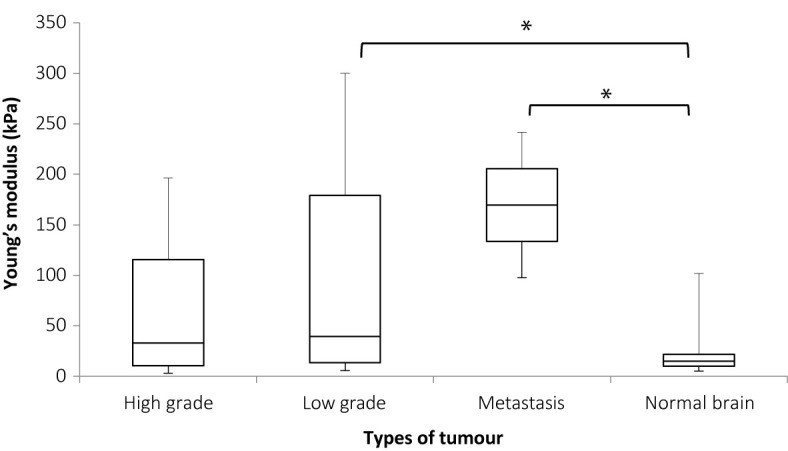
Box and whiskers plot of Young’s modulus distributions for various tumor types. The upper and lower bounds of the box were the third and first quartiles, respectively, while the line within the box was the median. The upper and lower whiskers were maximum and minimum values, respectively. *There was a significant difference between the Young’s modulus values for low grade tumor and normal brain (p = 0.036) and between metastases and normal brain (p = 0.007) but the differences between high grade and normal brain (p = 0.125), high grade and low grade (p = 0.220), metastases and high grade (p = 0.132), and low grade and metastasis (p = 0.288), were not significant. Mann Whitney U test was used to perform statistical analysis.